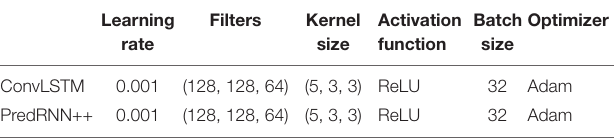
TABLE 1 | ConvLSTM and PredRNN++ hyper-parameters.